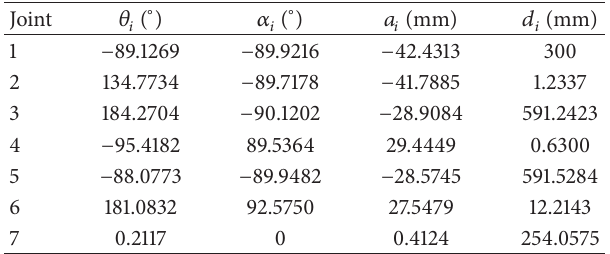
Table 4: Identified values for the AACMM model parameters by L- M